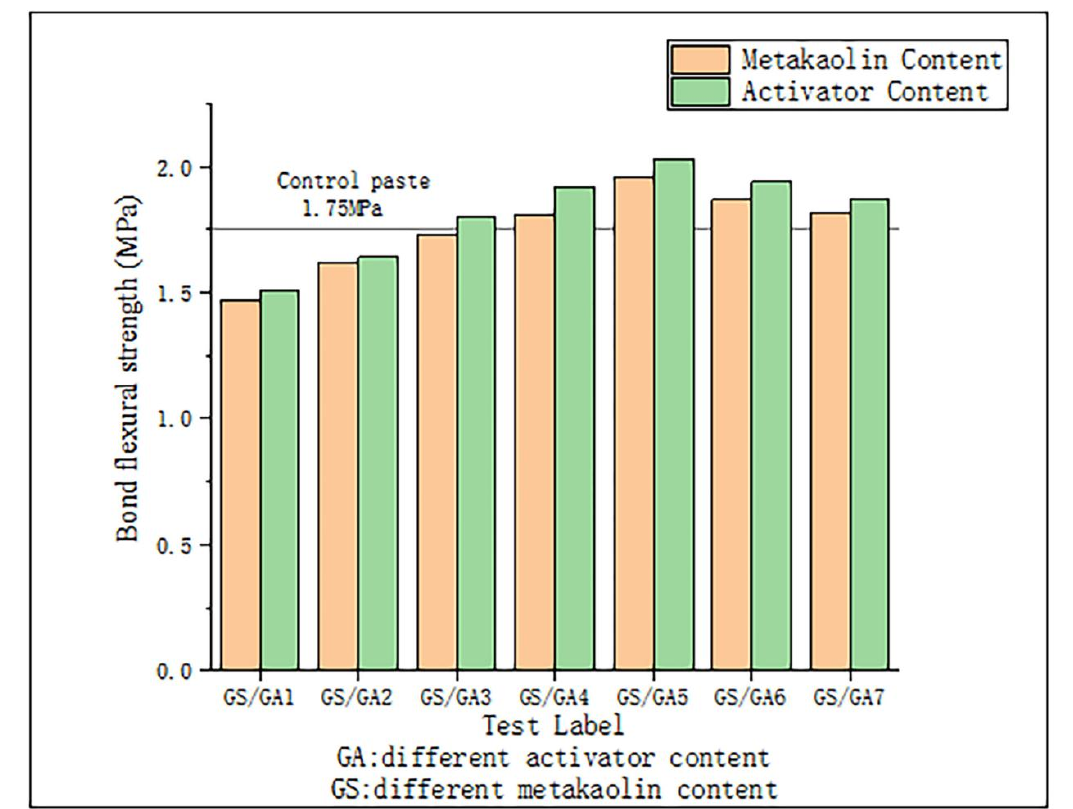
Figure 13. Bond flexural strength of GA/GS and cement paste.